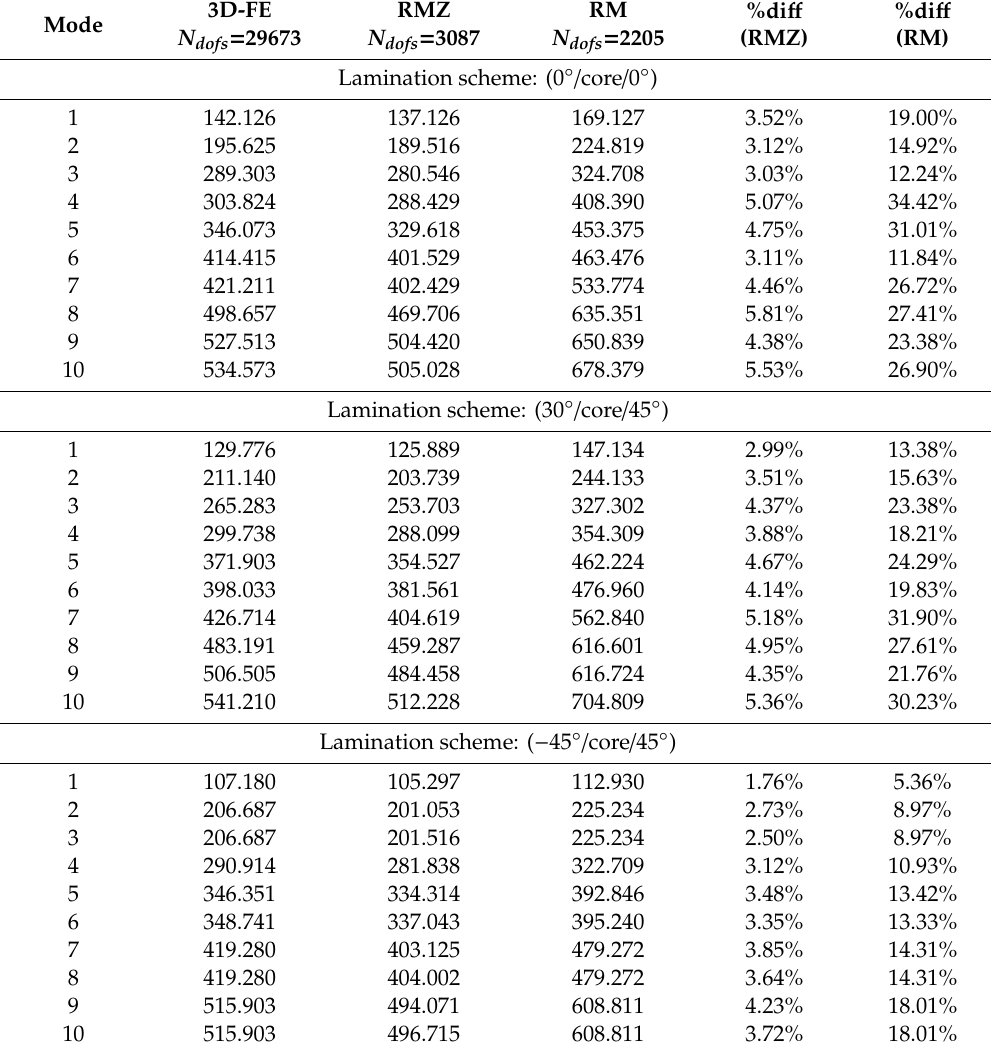
Table 3. First ten natural frequencies of a sandwich plate with an inner soft-core for three di ff erent lamination schemes: comparison with the 3D-FE